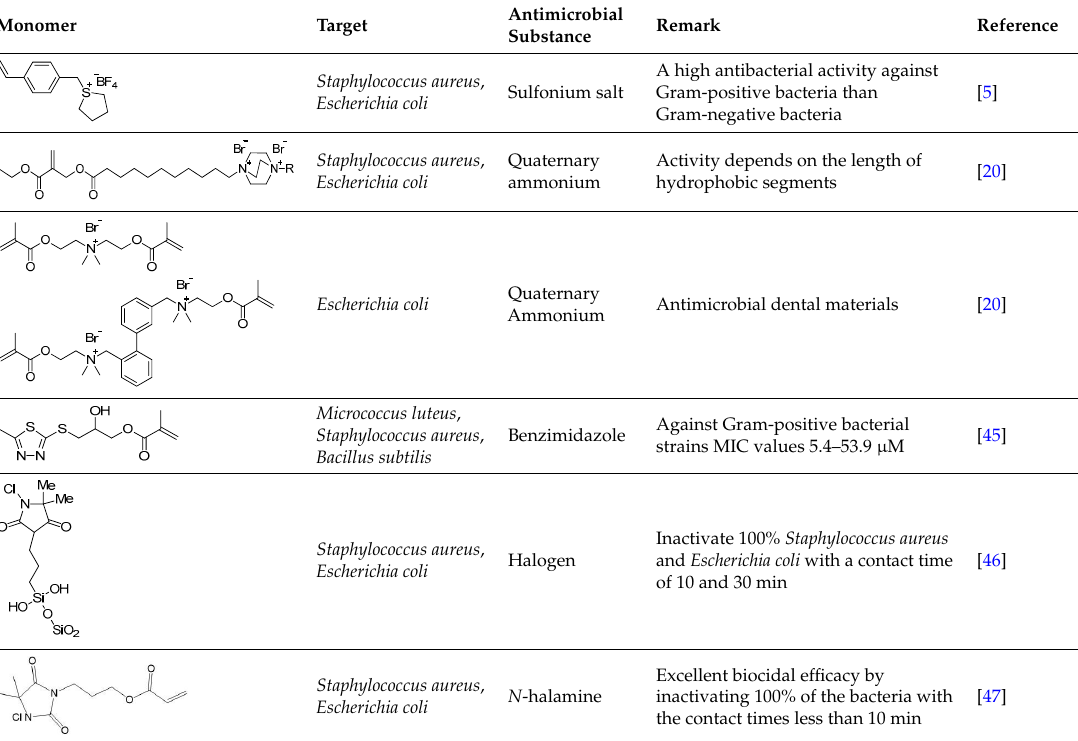
Table 4. Examples of polymeric biocides for antimicrobial applications.